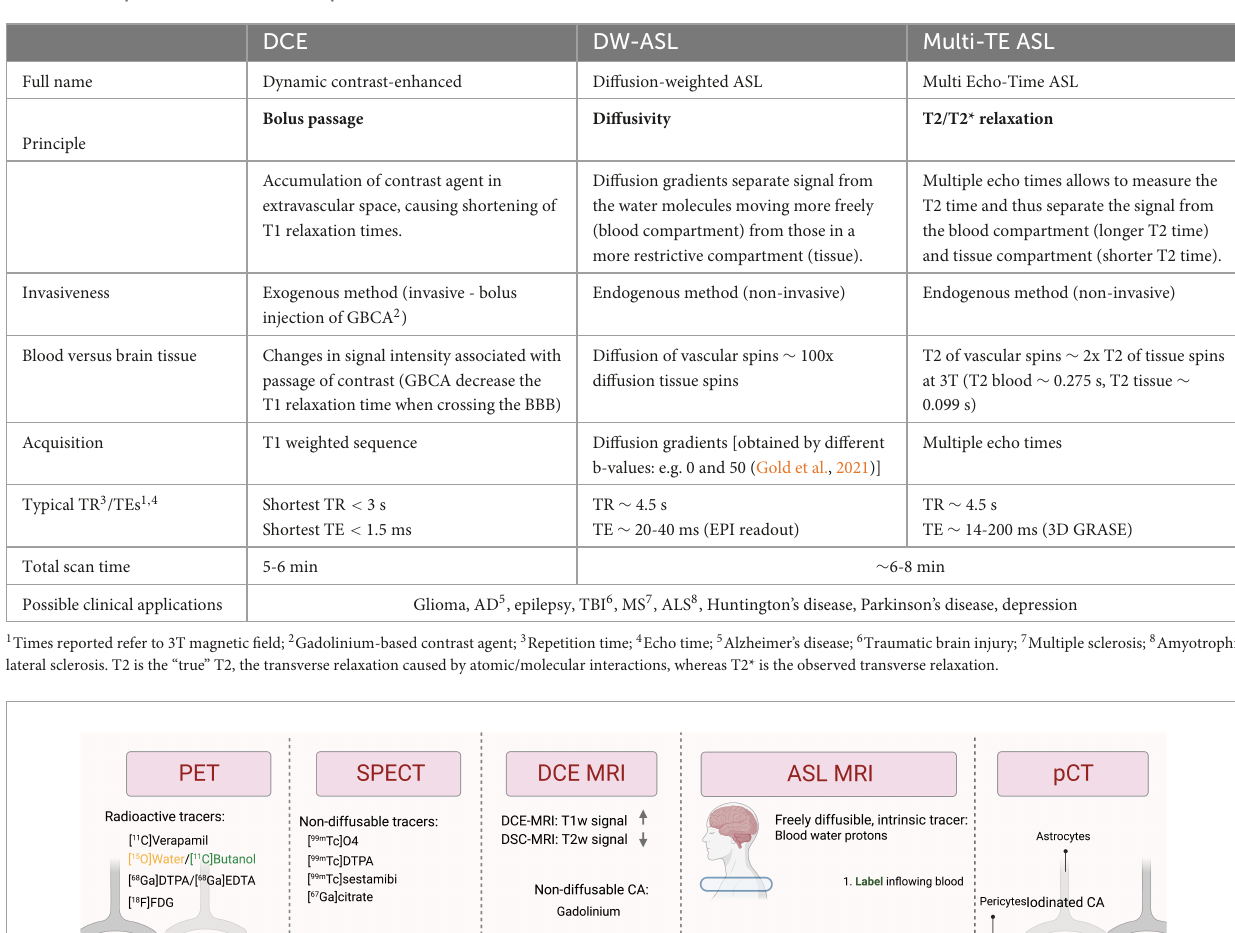
TABLE 2 Comparison of the technical specifications of DCE, DW-ASL and Multi-TE ASL.